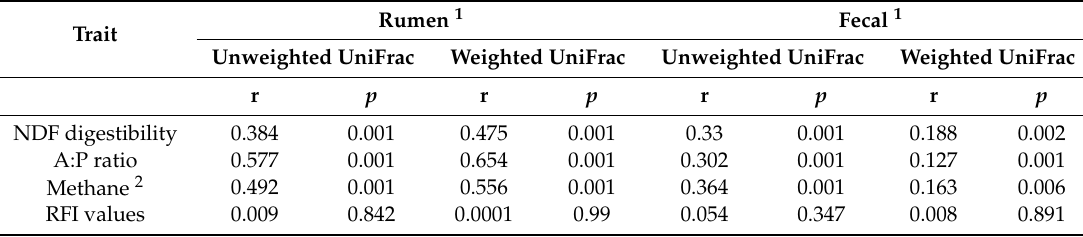
Table 2. Correlation of bacterial community structure to the animal traits: NDF digestibility in total tract, acetate-to-propionate (A:P) ratio in rumen liquid, methane yield (L/kg dry matter intake (DMI)), and residual feed intake (RFI) values.